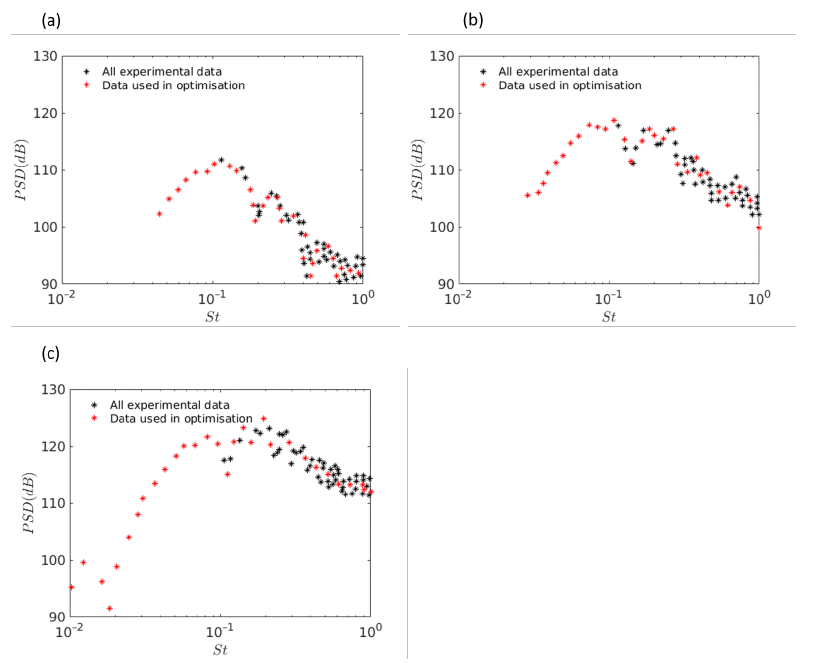
Figure 4. Points chosen from experimental data to calculate the objective function ( a ) Ma = 0.5 ( b ) Ma = 0.7 ( c ) Ma =